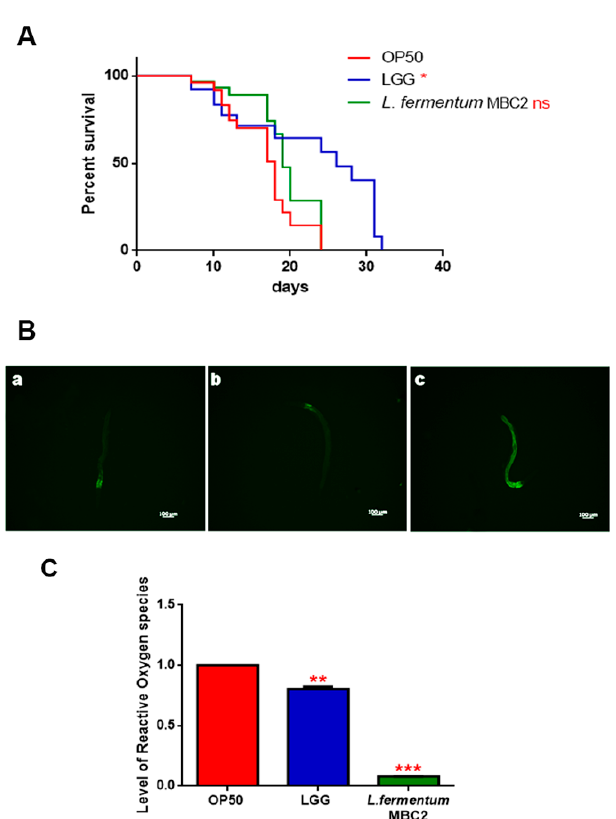
Figure 5. Effect of L. fermentum MBC2 on PEPT-1 mutant strain and analysis of aging biomarkers. ( A ) Kaplan-Meier survival plot of PEPT-1 worms fed L. fermentum MBC2. Lifespans of OP50- and LGG-fed animals are reported as controls; n = 60 for each data point of single experiments. ( B ) Analysis of autofluorescence of lipofuscin in PEPT-1 worms fed OP50 ( a ), LGG ( b ) and L. fermentum MBC2 ( c ) at day 13. Ten worms were used for each measurement. Scale bar = 100 µ m. ( C ) Measurement of ROS levels in L. fermentum MBC2-, LGG- and OP50-fed PEPT-1 mutants at 1 day of adulthood. Statistical analysis was evaluated by one-way ANOVA with the Bonferroni post-test; asterisks indicate significant differences (** p <0.01; *** p <0.001). Bars represent the mean of three independent experiments.